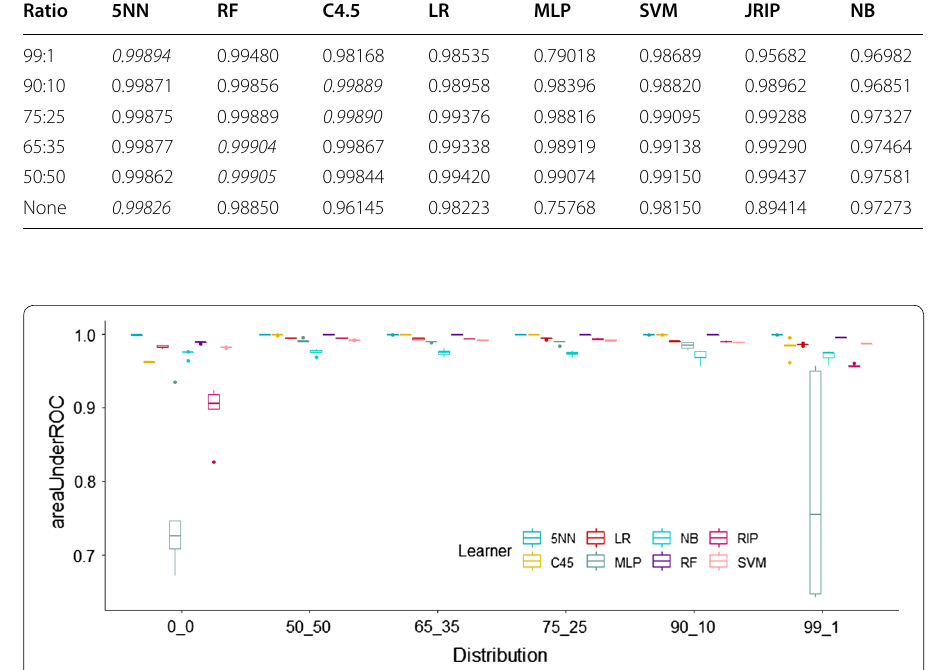
Fig. 2 AUC results for all